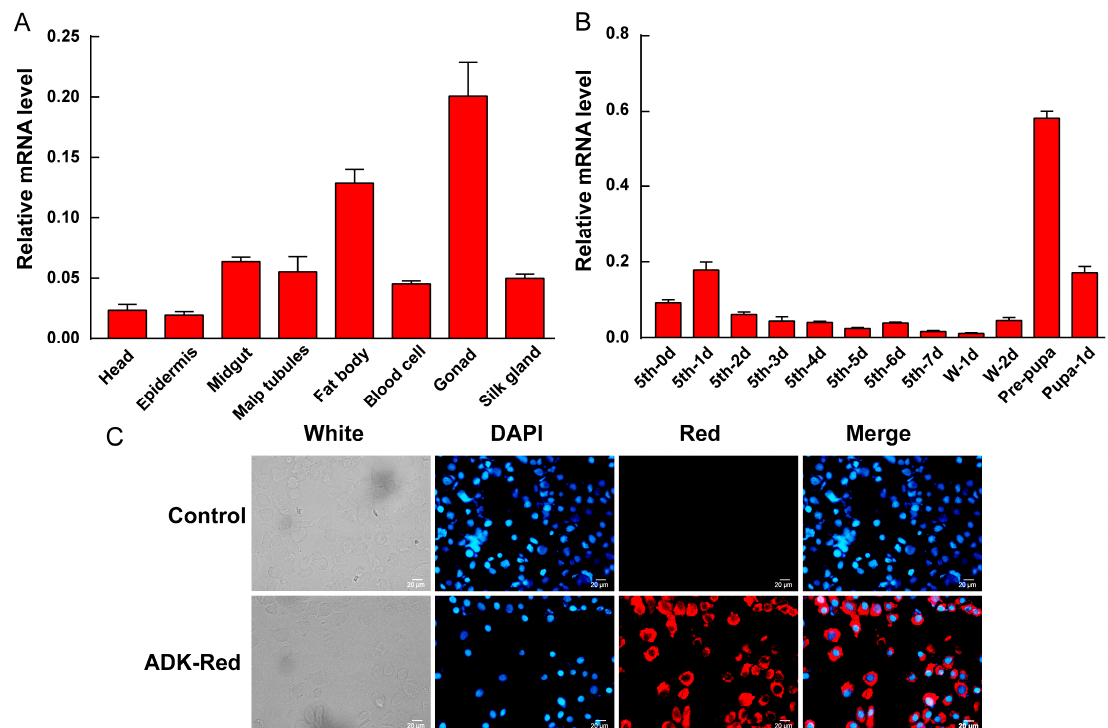
Figure 4. Expression profile and cellular location of BmADK. ( A ) Expression profile of BmADK in the head, malpighian tubules, gonad, midgut, fat body, silk gland, blood cell, and epidermis of the silkworm on the third day of the fifth instar. ( B ) Expression profile of BmADK in the silk gland at the mRNA level from the first day of the fifth instar to the first day of the pupa of the silkworm. 5th, fifth instar stage; W, wandering stage; Pupa, pupal stage. ( C ) Fluorescence location of BmADK in the BmE cells. “Red” is the signal from recombinant BmADK. The cells were stained with DAPI for 20 min. Scale bar is 20 μ m.